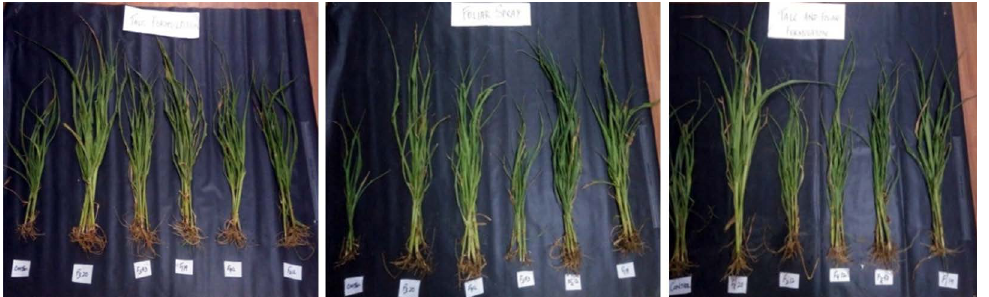
Fig. 2. Morphometric observation of uprooted plants in field Table 3. Morphometric data of seedlings in pot experiment. Growth Control